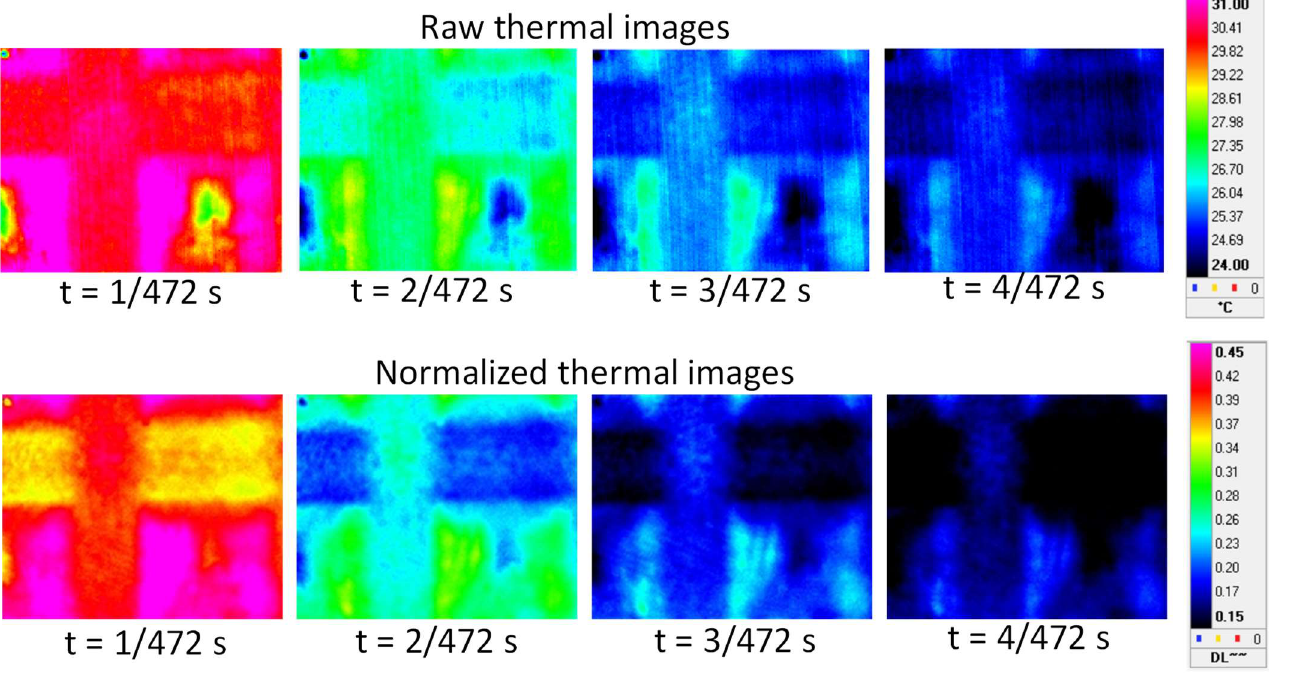
Figure 3. Raw and normalized thermal images of the ROI at different time frames after the flash. gion where horizontal and vertical hatches cross; (2) the horizontal single hatch (P1H); (3) the vertical single hatch (P1V); and (4) the uncoated PP. Figures 4b,c and 5b,c plot the